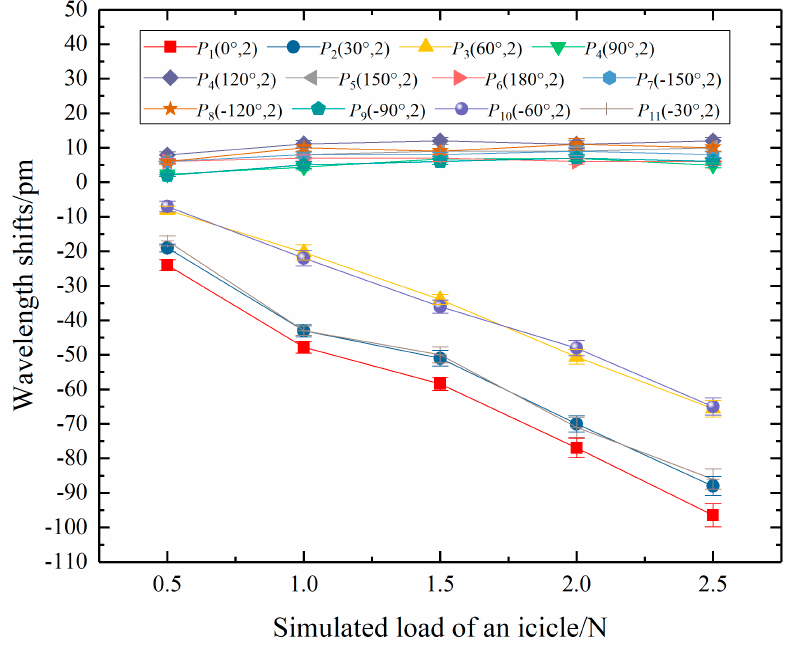
Figure 7. The relationship between the wavelength shift of FBG102 and simulated load generated on different positions.